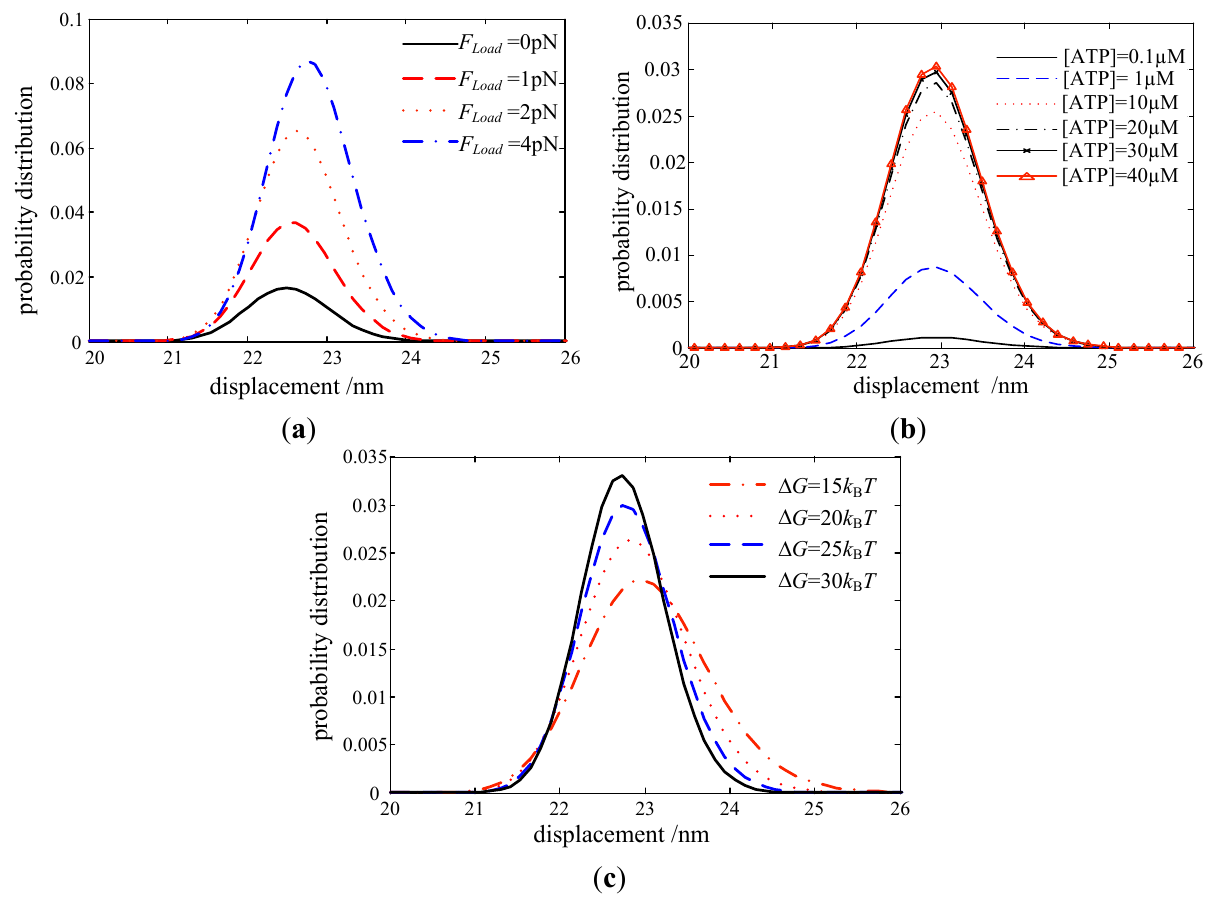
Figure 3. Probability density distribution of the molecular motor in relation to ( a ) various loads with [ATP] = 30 micromolar; ( b ) ATP concentration with load F Load = 6 pN; and ( c ) potential profiles with F Load = 6